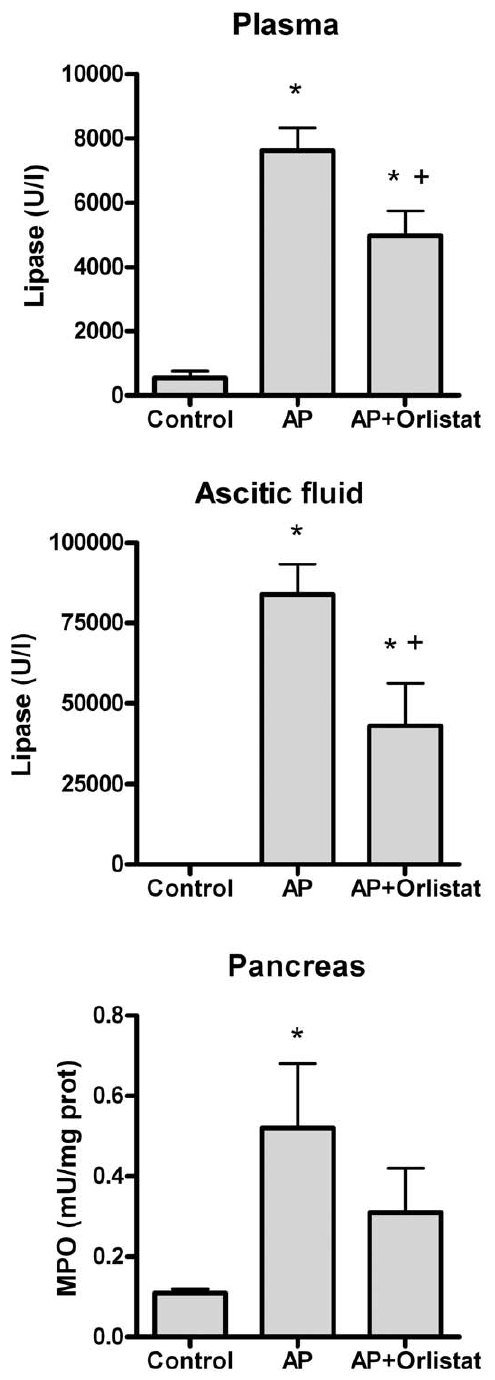
Figure 1. Acute pancreatitis (AP) results in significant increases in lipase activity in plasma and ascitic fluid as well as in myeloperoxidase (MPO) in pancreas. Orlistat treatment signifi- cantly inhibits lipase activity but also the increase in MPO activity in pancreas. * = p , 0.05 vs control; + = p , 0.05 vs AP.